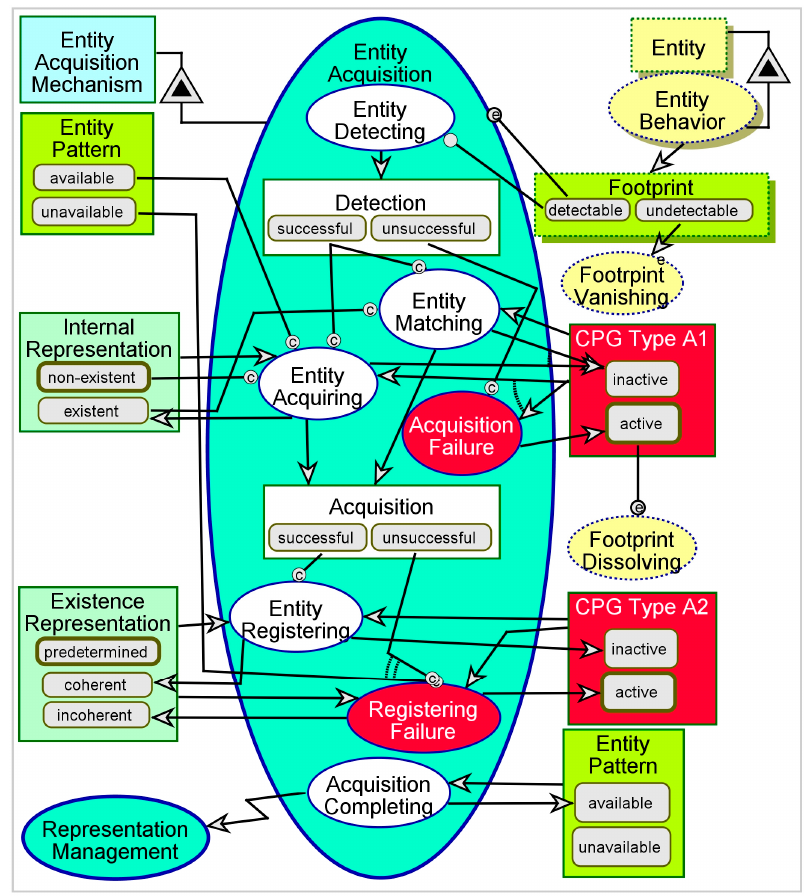
Figure 4. The Entity Acquisition process.